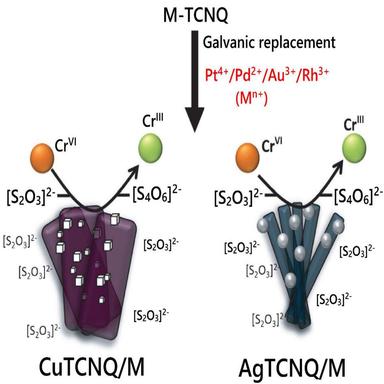
Schematic representation of the GR of M-TCNQ to M-TCNQ/M and the conversion of Cr(VI) to Cr(III) with S2O3 2 ions 'Mullane, 2013).